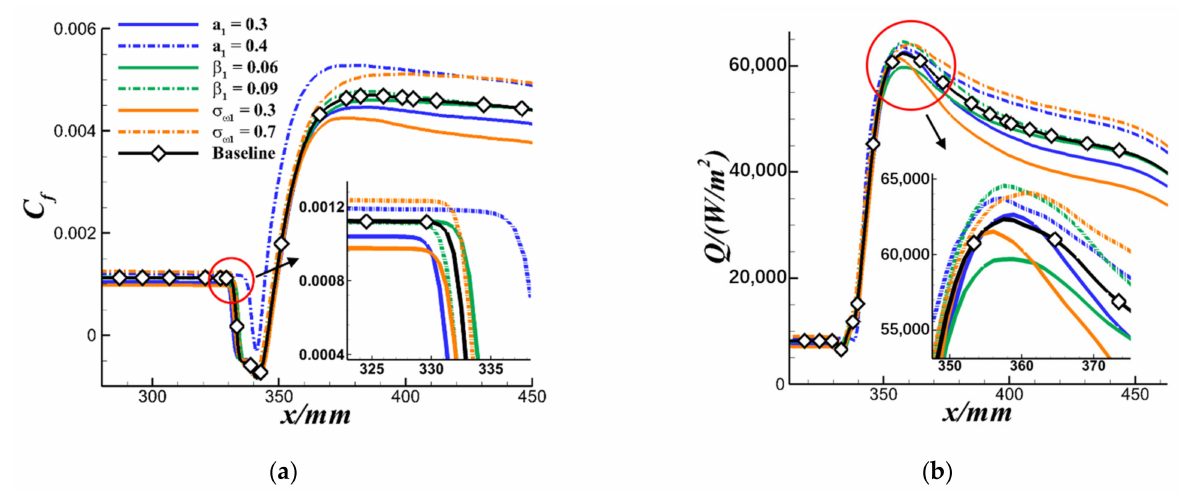
Figure 15. Distribution of the wall properties on the plate for test cases. ( a ) Skin friction; ( b ) wall heat flux.